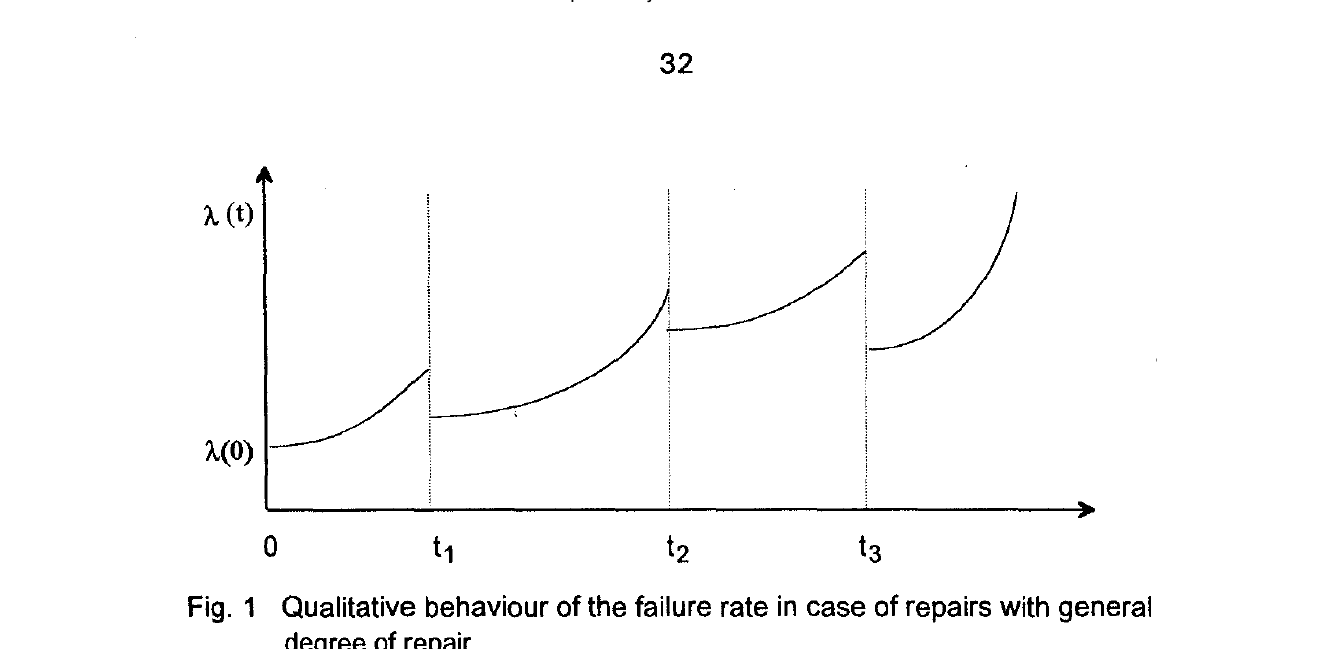
Fig. 1 Qualitative behaviour of the failure rate in case of repairs with general degree of